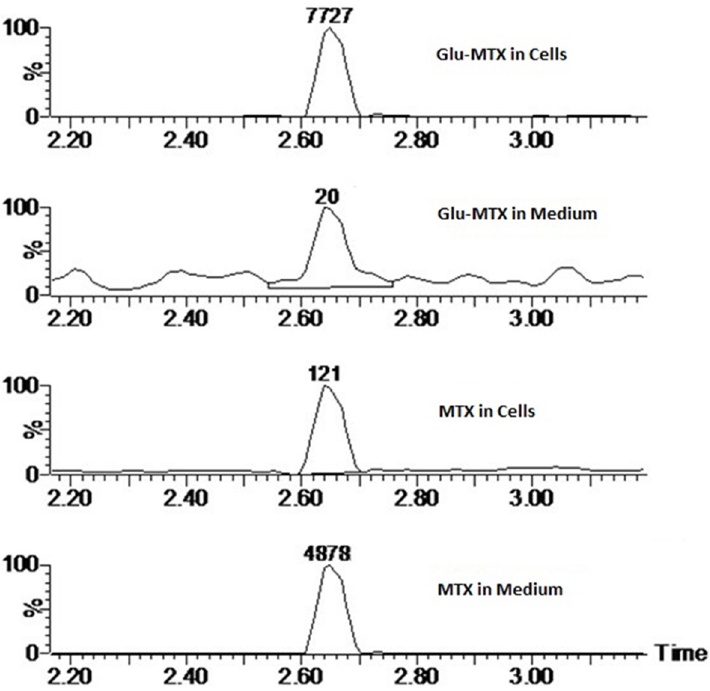
Figure 8. Extracted ion chromatograms of MTX (455.18 m / z ) in cell extracts and culture medium. The peak area was shown above the peaks.